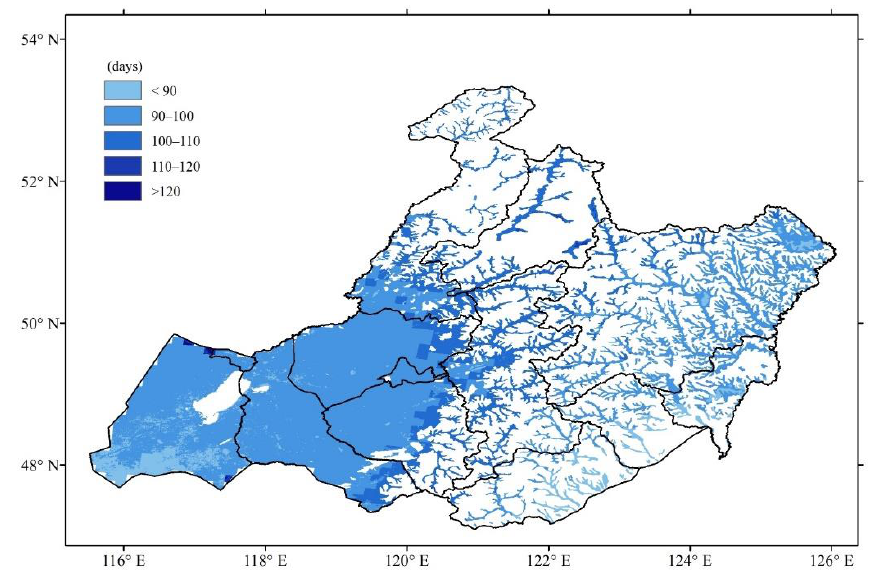
Figure 13. The average annual chilling days (CD) during